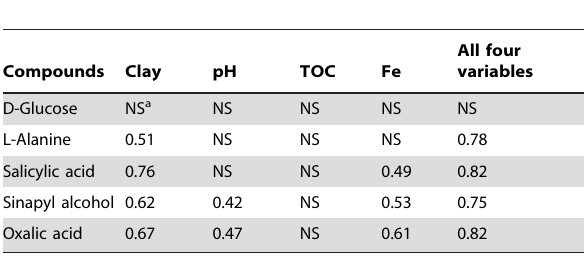
Table 3. Linear regression coefficients (R 2 ) between maximum sorption capacity ( Q max ) and soil